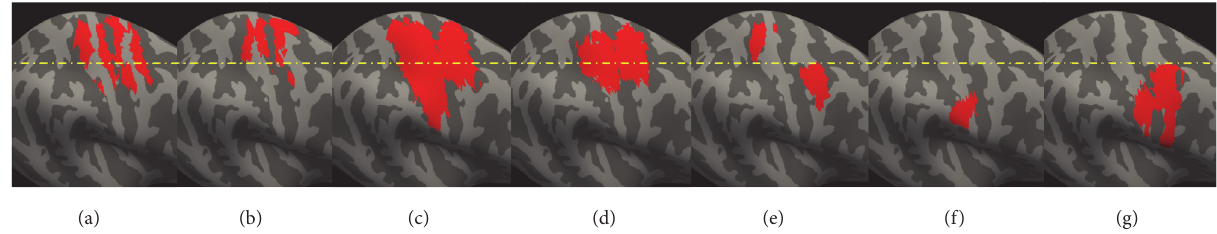
Figure 4: Ipsilateral hemisphere to the side of the affected nerve injury. (a) ReHo resting-state fMRI result. (b) ICC resting-state fMRI result. (c) Increased activation evoked by contralateral hand movement in BP patients. (d) Increased activation evoked by contralateral hand movement in healthy controls. (e) Increased activation evoked by contralateral facial sensory stimulation in BP patients. (f) Increased activation evoked by contralateral facial sensory stimulation in healthy controls. (g) Increased activation evoked by mouth movement in healthy controls.